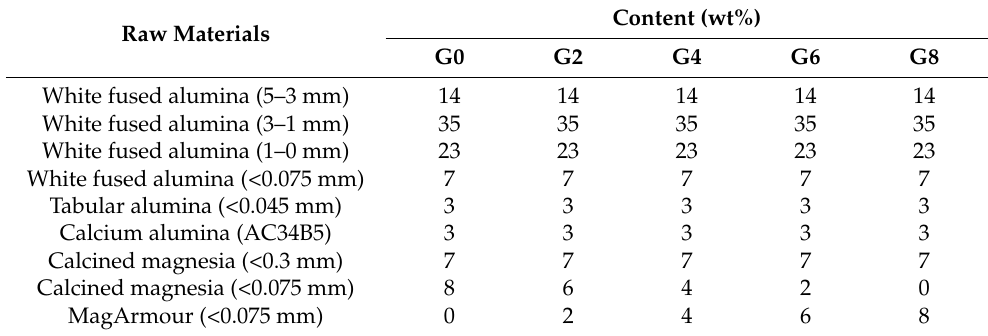
Table 1. Formulations of alumina–magnesia-based dry ramming mixes. Raw